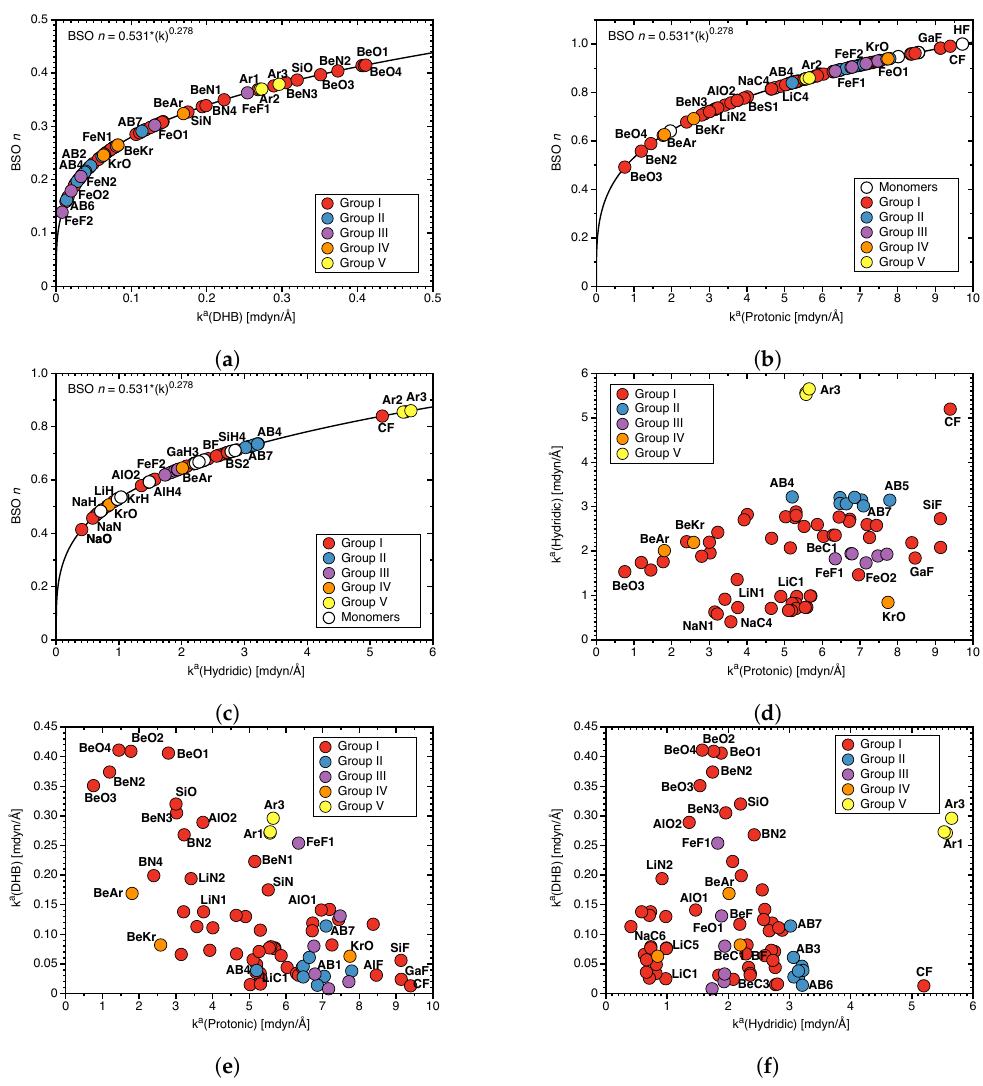
Figure 2. ( a ) BSO n values for DHB, ( b ) BSO n values for protonic parts of DHBs, and ( c ) BSO n values for hydridic parts of DHBs calculated from the corresponding local mode force constants as described in the text. ( d ) Correlation between k a (Protonic) and k a (Hydridic), ( e ) between k a (Protonic) and k a (DHB), ( f ) between k a (Hydridic) and k a (DHB).